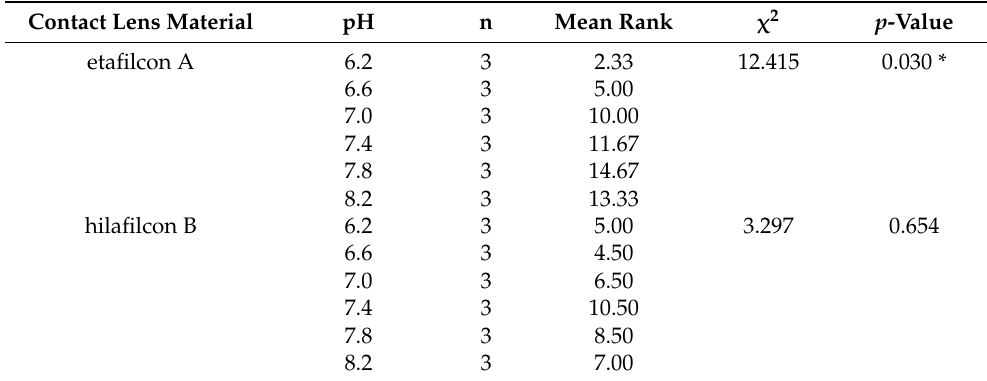
Table 3. The results of statistical analysis on the PZC of etafilcon A and hilafilcon B equilibrated in PBS solution (pH 6.2-8.2). A repeated measures Kruskal–Wallis test was used for statistical analysis; * p < 0.05.